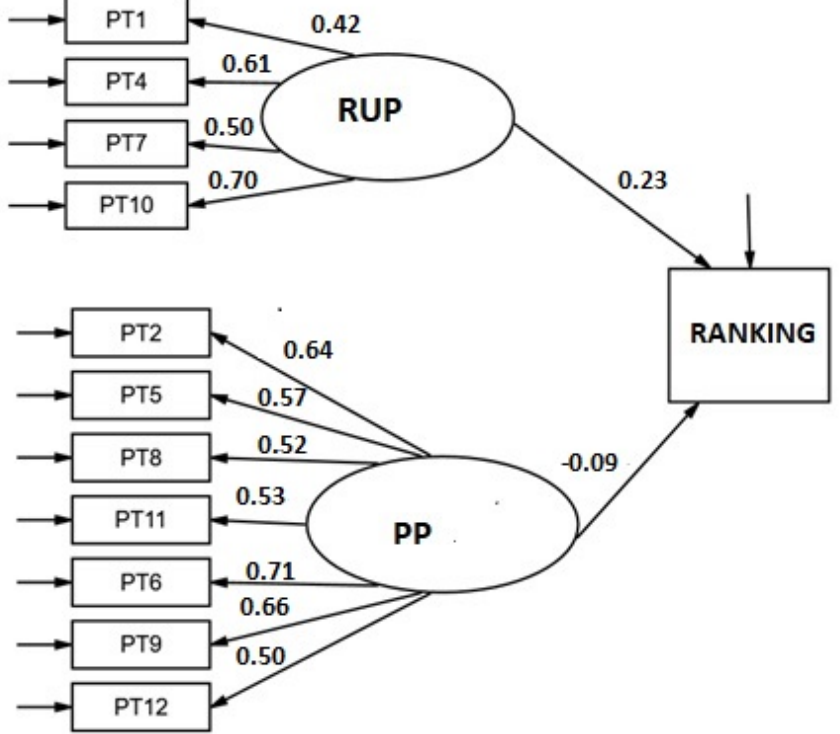
Figure 4. Structural model for the relationship between the latent variables of the Persistence scale and ranking. Standardized weights.